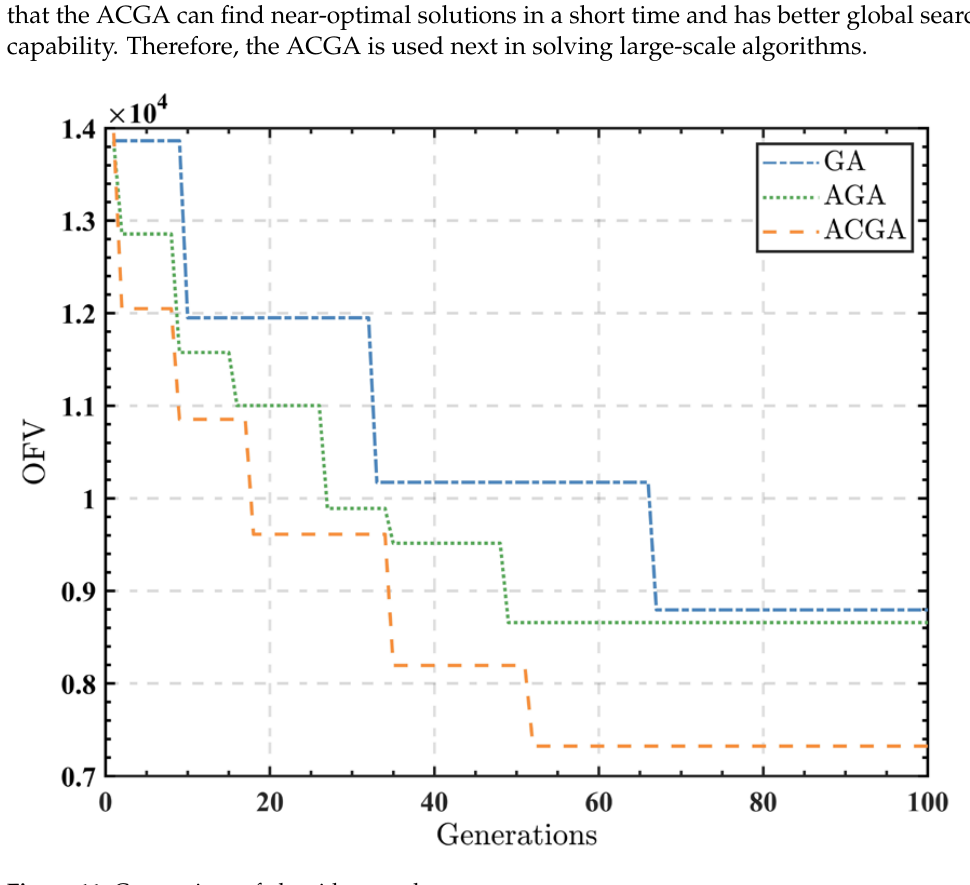
Figure 11. Comparison of algorithm results.